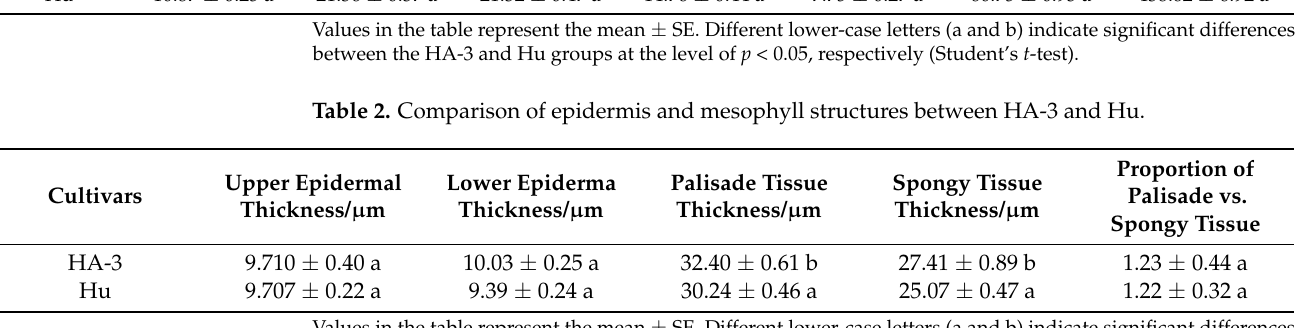
Values in the table represent the mean ± SE. Different lower-case letters (a and b) indicate significant differences between the HA-3 and Hu groups at the level of p < 0.05, respectively (Student’s t -test). Table 3. Comparison of leaf vein structure between HA-3 and Hu.